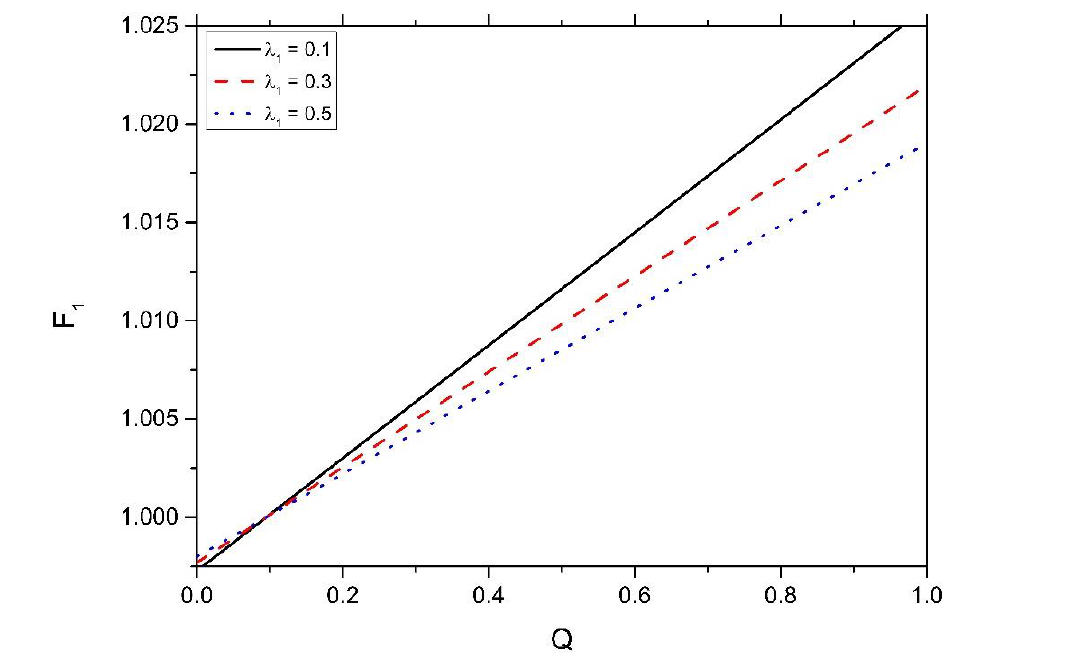
N = 0.3, N = 0.4,  =0.5,  = 0.01, Br = 0.3, b t   = , F = 0.1, z = 0.5. 6